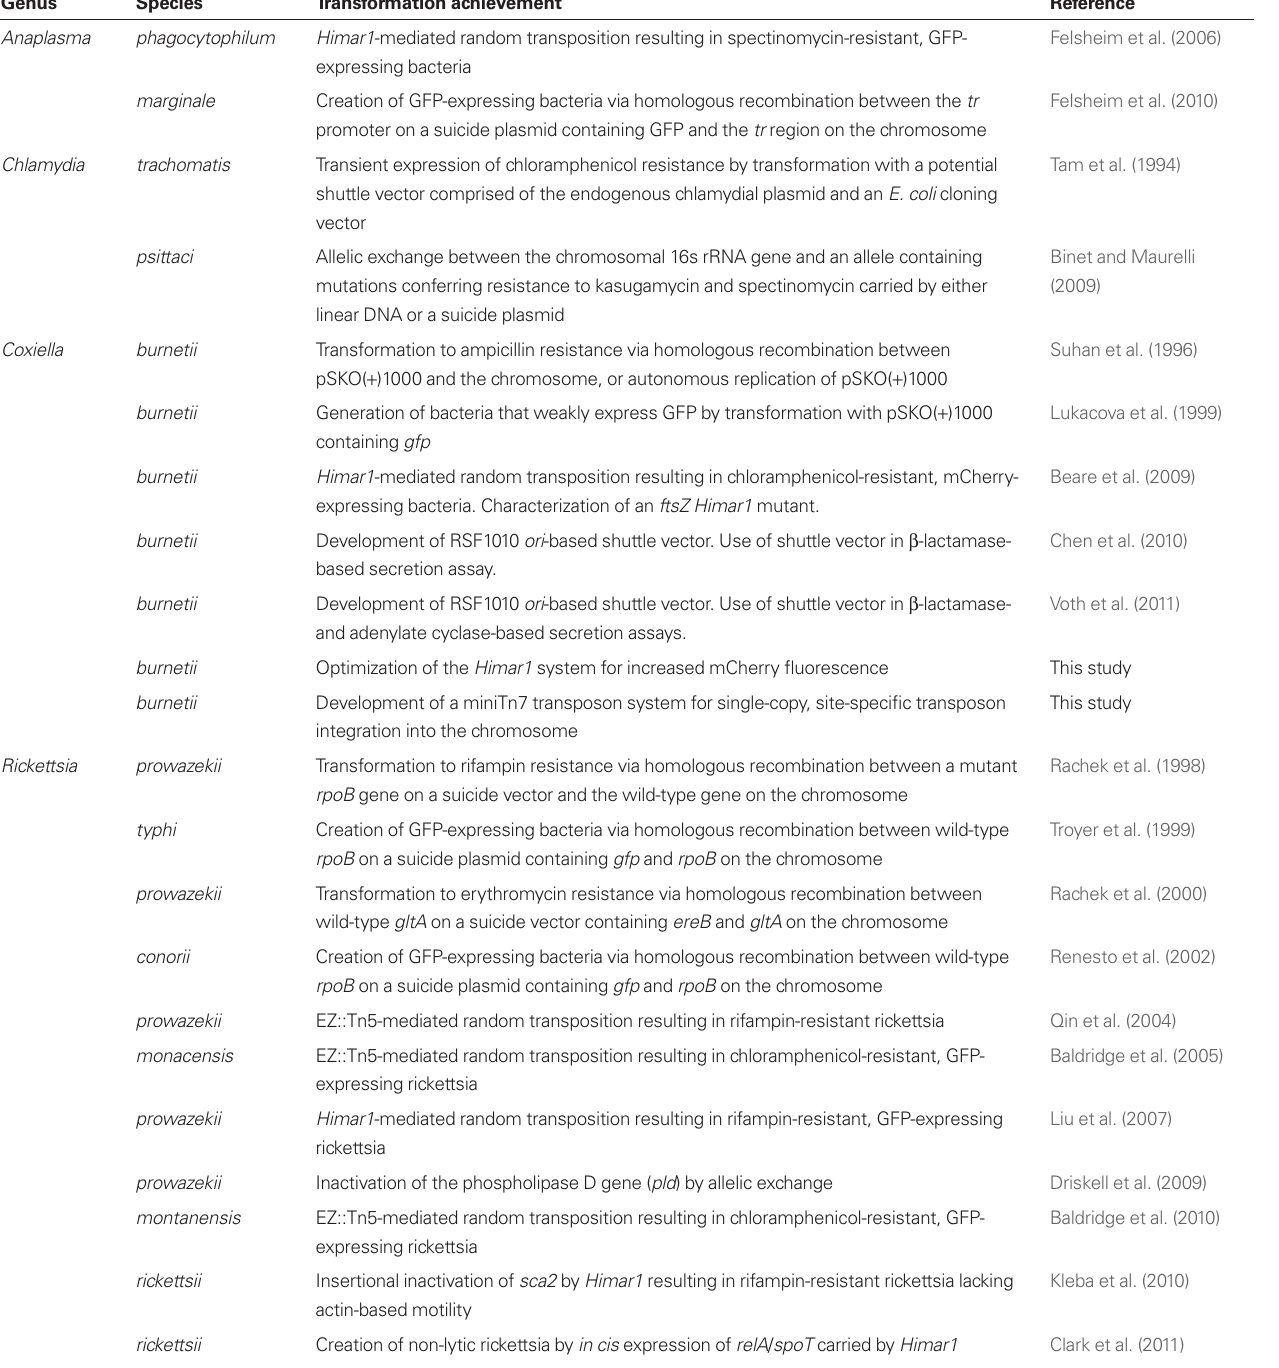
Table 1 | History of genetic transformation of obligate intracellular bacterial